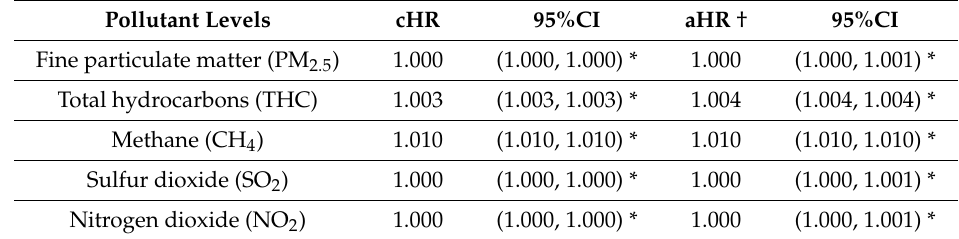
Table5. Comparisonsofdi ff erencesinrecurrentheadachesincidencesandassociatedHRsinparticipants exposed to various annual average concentrations of air